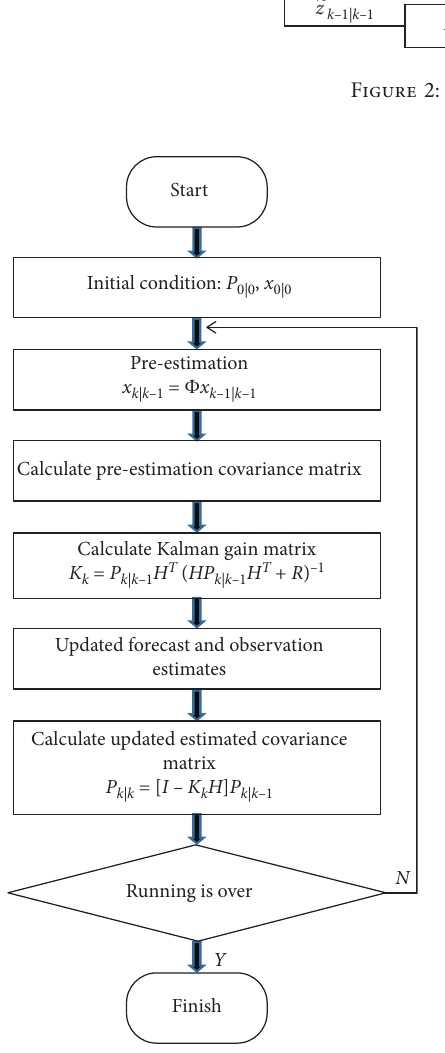
Figure 3: Discrete Kalman filter algorithm subroutine